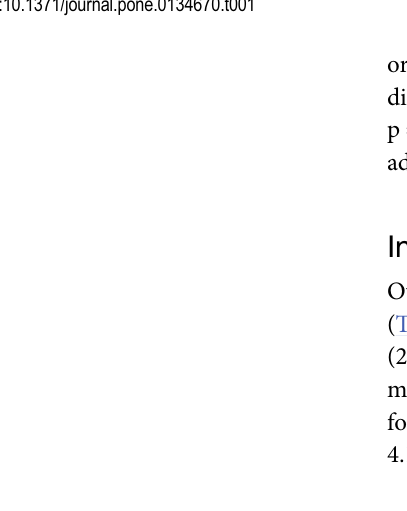
(Table 3). Patients taking preoperative aspirin had no increase in days of chest tube drainage